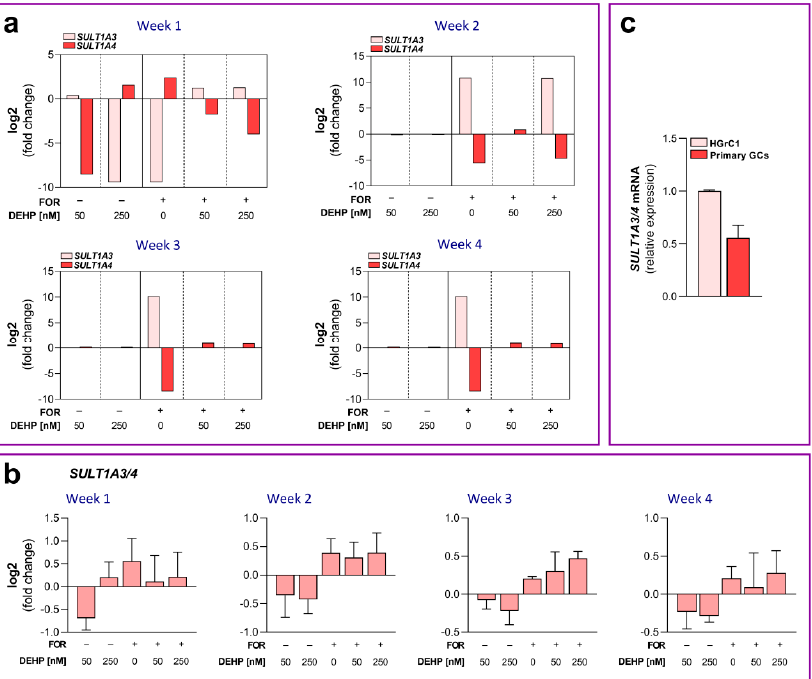
Figure 8. Expression of SUL1A3 and SULT1A4 mRNA in DEHP-exposed HGrC1 cells. ( a ) RNAseq data on SUL1A3 and SULT1A4 expression in HGrC1 cells after 1, 2, 3, and 4 weeks of the repeated DEHP50 and DEHP250 exposure under the basal and FOR-stimulated conditions. ( b ) RT-qPCR was used to evaluate SULT1A3/4 mRNA expression in HGrC1 cells. Results are expressed relative to the control that was set as 0 in each week of exposure. ( c ) RT-qPCR was used to evaluate SULT1A3/4 mRNA expression in the primary culture of human granulosa cells and HGrC1 cells. Results are ex- pressed relative to the expression level in HGrC1 cells that was set as 1 in each week of exposure. In RT-qPCR experiments, each data point represents the mean ± SEM of three independent experiments.